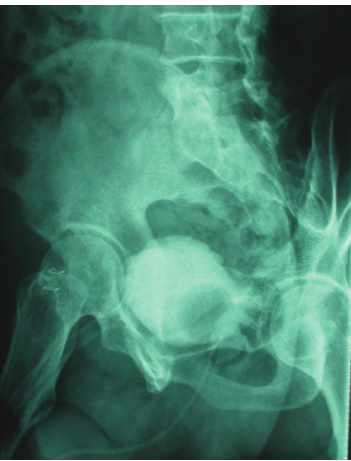
Figure 3: Postoperative oblique cystography with no extravasation.